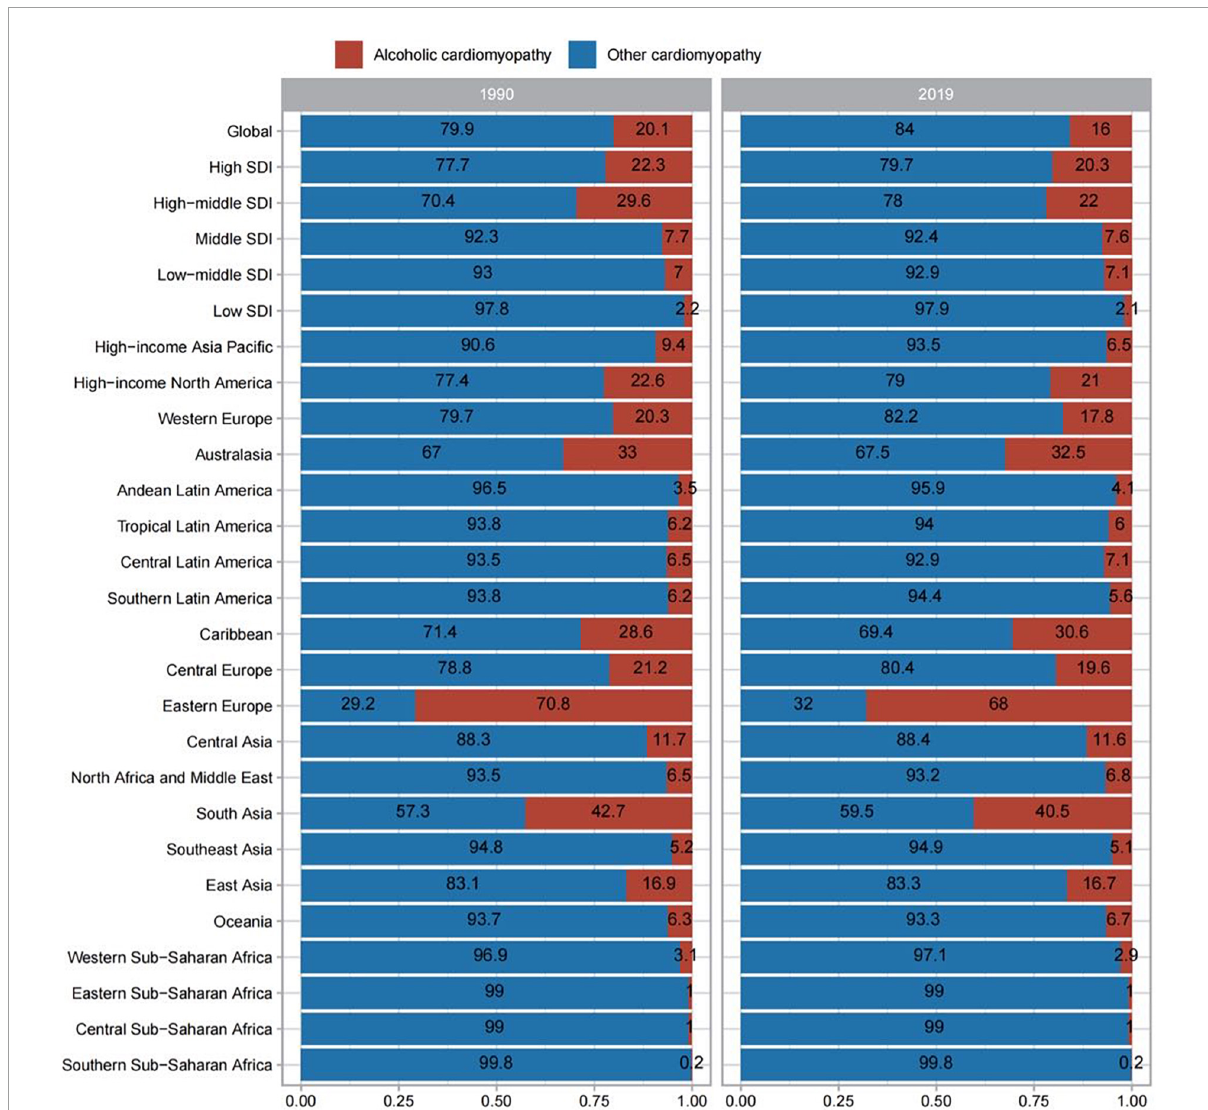
FIGURE2 Contribution of alcoholic cardiomyopathy, and other causes to cardiomyopathy prevalence, both sexes, globally and by region, in 1990 and 2019.